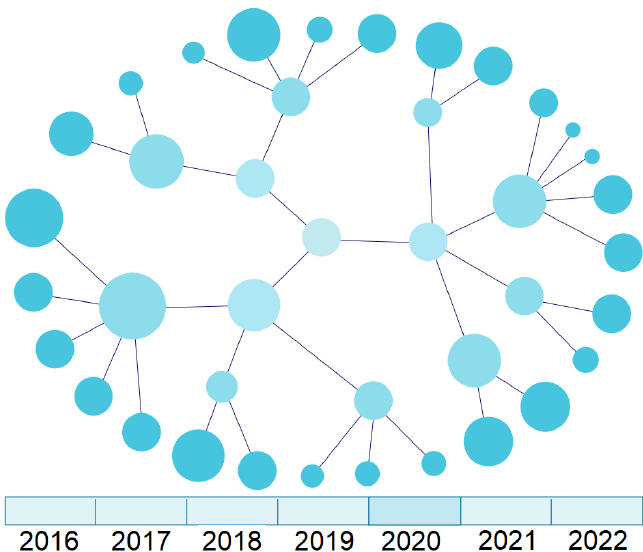
Figure 8. UI mockup of a temporal chart visualisation (graph-level